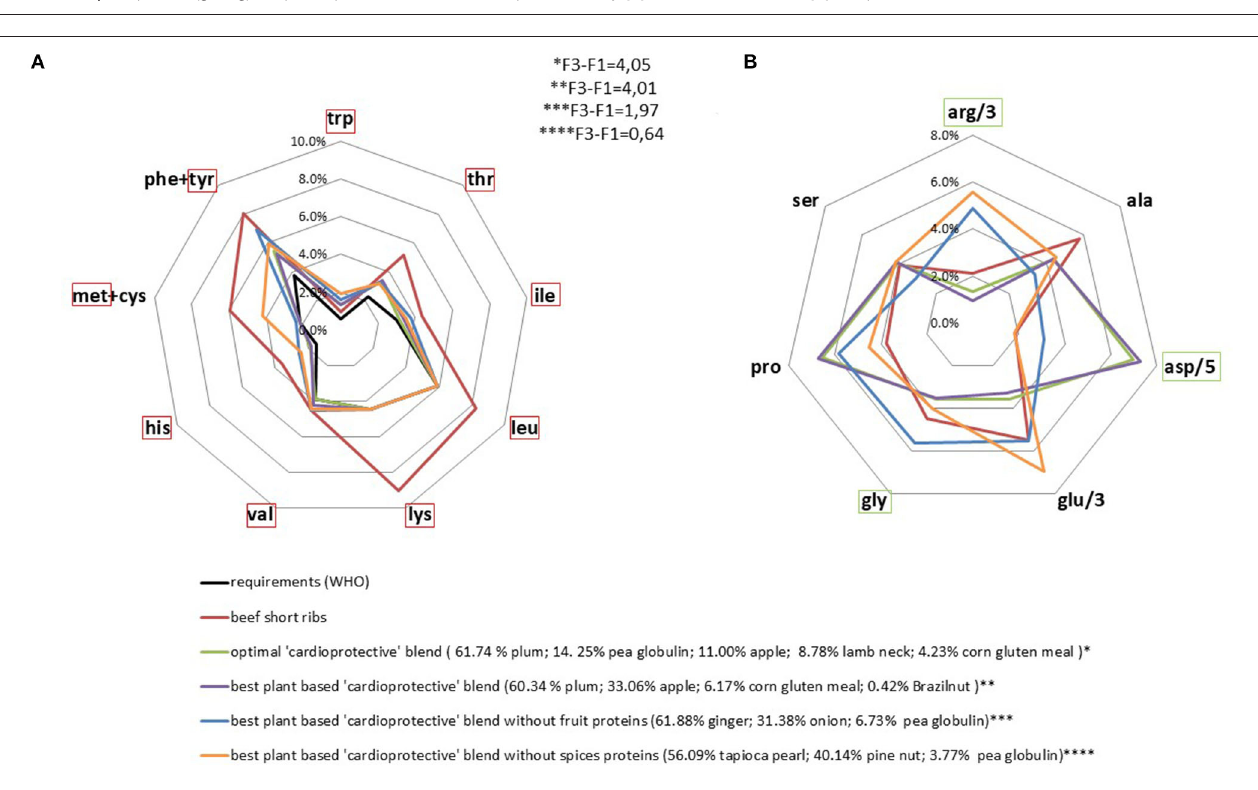
FIGURE 4 | AA profiles (% of protein intake) of optimal protein blends based on a lower cardiovascular mortality risk. Requirements and beef AA profiles are presented for comparison. IAA requirements were set as the minimum content. The indispensable amino acids in the red frame were minimized, yet constrained to be higher than requirement value (A) and the non-indispensable amino acids in the green frame were maximized (B) .